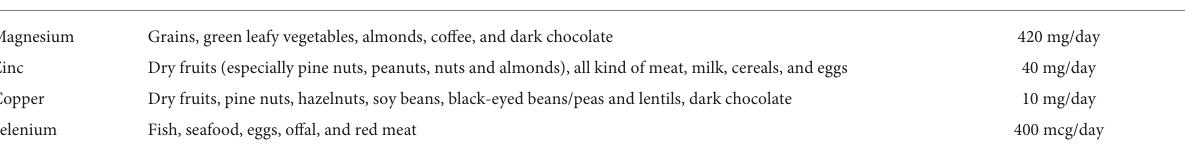
TABLE 7 Food sources of trace metals and recommended upper